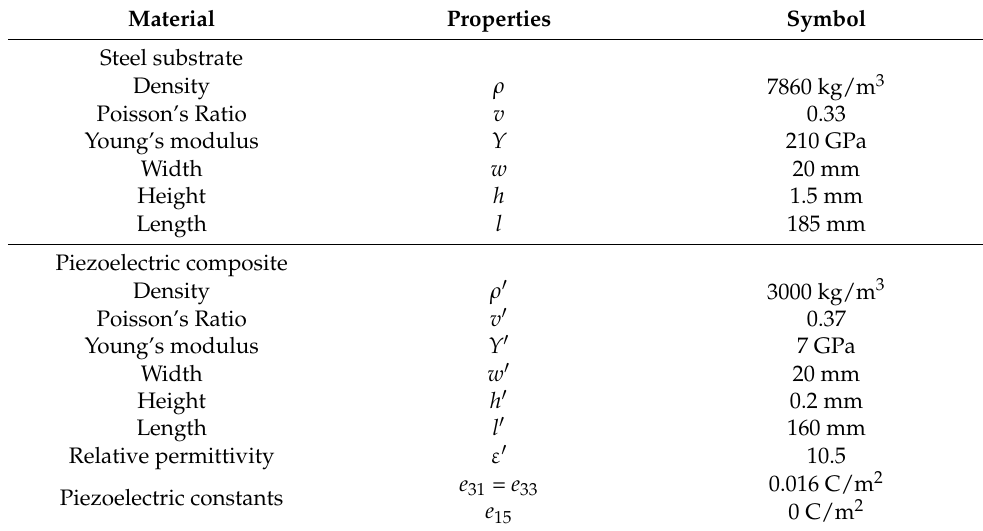
Figure 5. FEM of the bidirectional coating-sensor-based COMSOL multiphysics: ( a ) 4PB configuration; ( b ) mesh pattern for physical simulation. Table 1. Parameters of the analytical model.